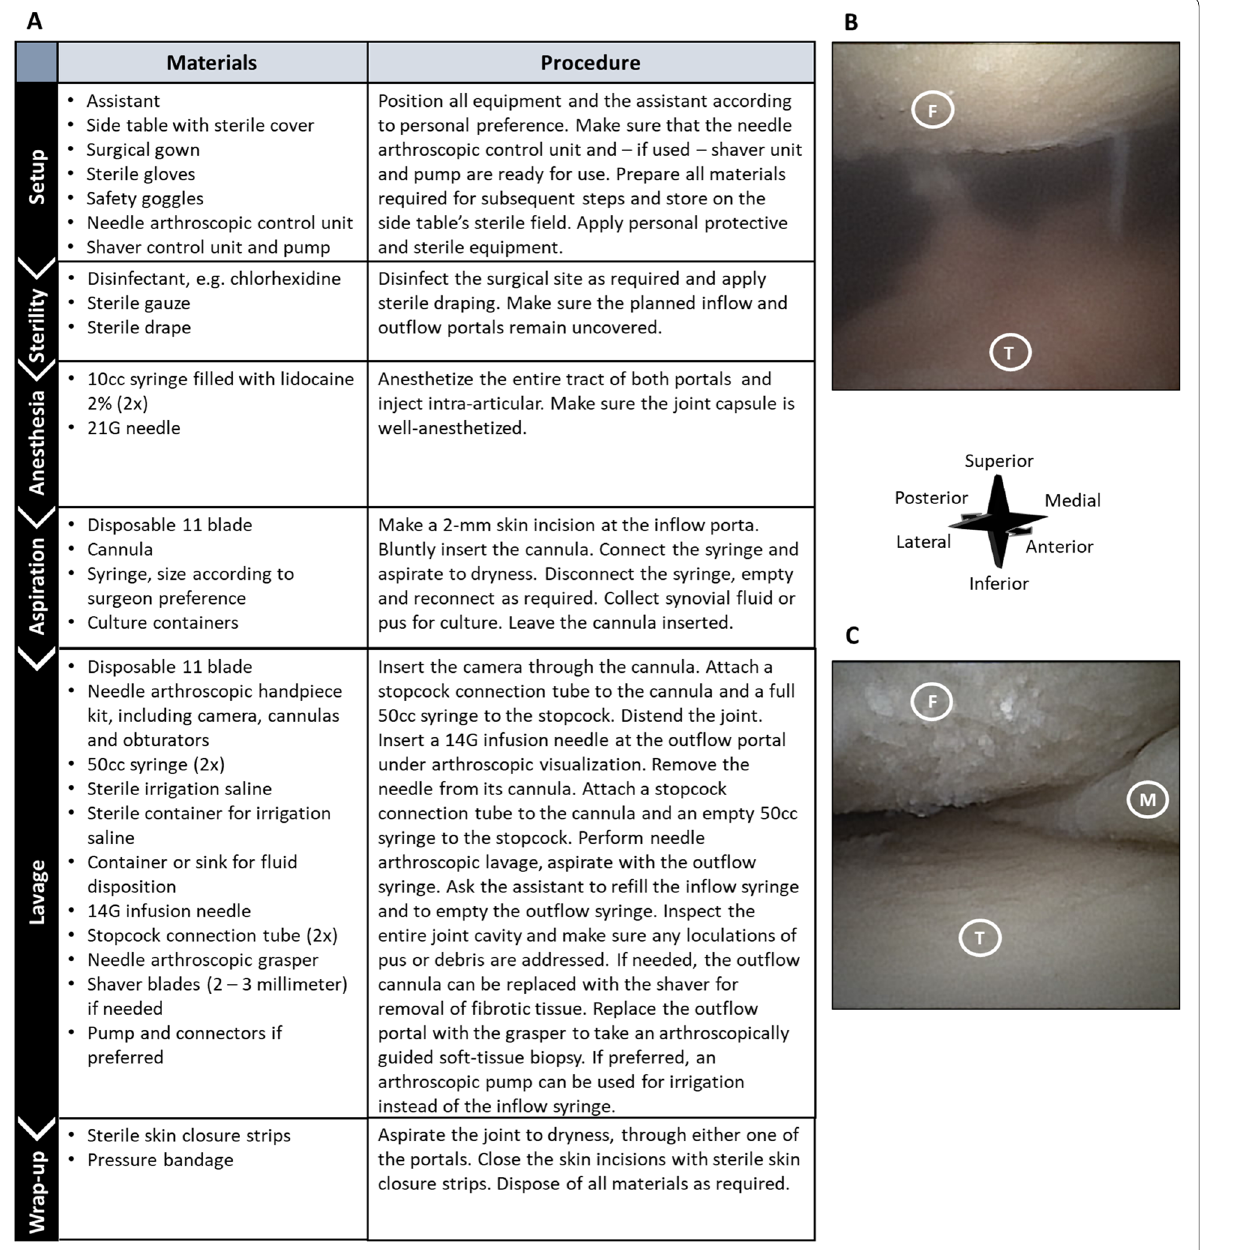
Fig. 1 With a stepwise approach ( A ), needle arthroscopic lavage of a suspected native joint bacterial arthritis ( B ) results in a clear joint ( C ). Local anaesthesia is described, yet all other steps equally apply to general or regional anaesthetic procedures. Intra-articular images B (before lavage) and C (after lavage) were taken from the same anterolateral portal in the same right knee. F indicates the femur, T indicates the tibia, M indicates